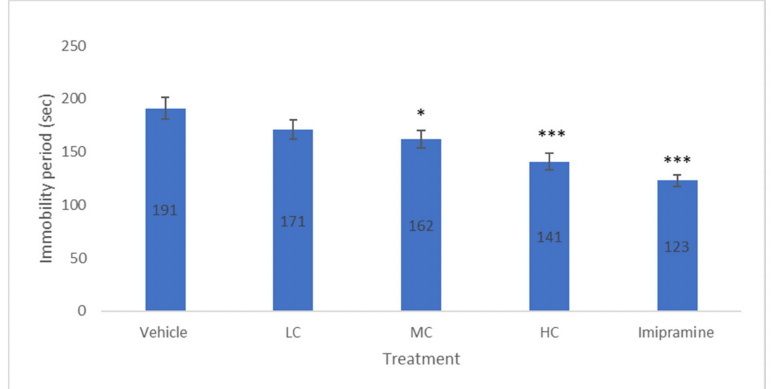
Figure 1. The changes in immobility period (sec) due to crocin and imipramine. Data were given as mean and standard error of mean. Each group had eight animals. Statistical analysis was performed by one-way analysis of variance (ANOVA) and post-ANOVA Tukey’s test; * p < 0.05, and *** p < 0.001 when compared to vehicle; LC—low dose of crocin; MC—medium dose of crocin; HC—high dose of crocin.